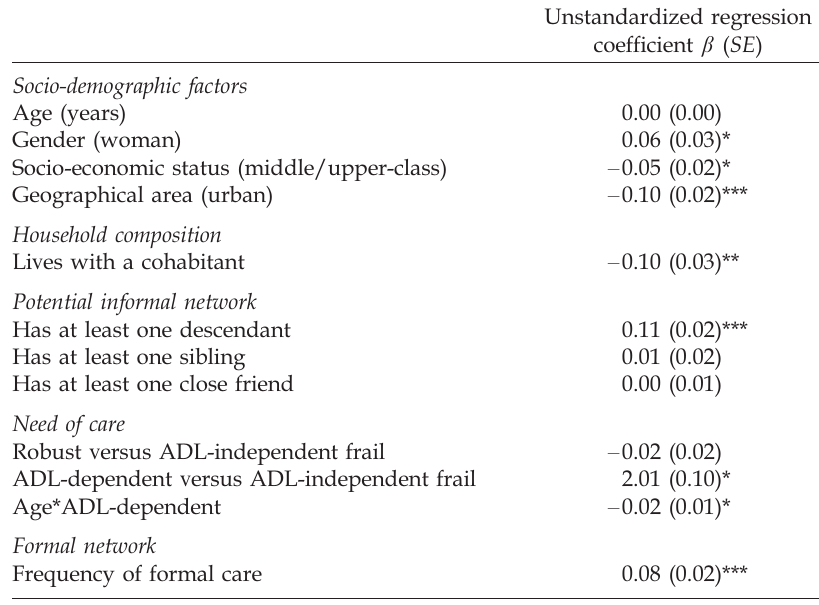
Table 4. Frequency of non-household informal ser v ices as a function of the frequency of formal care and controls: multile v el analysis ( n (cid:1)